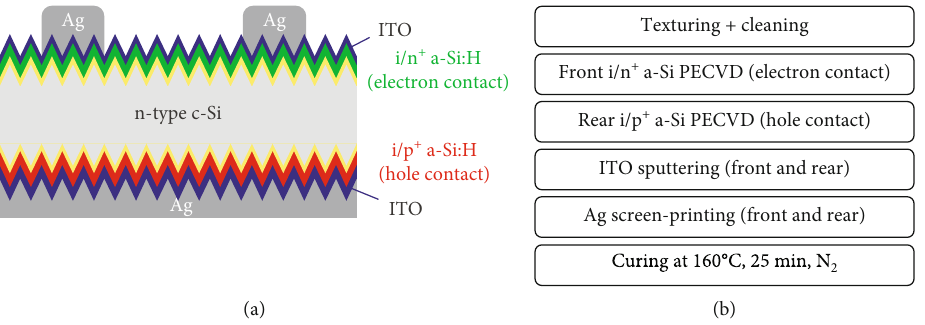
Figure 7: The cross-sectional schematic (a) and the process fl ow (b) of silicon heterojunction solar cells.